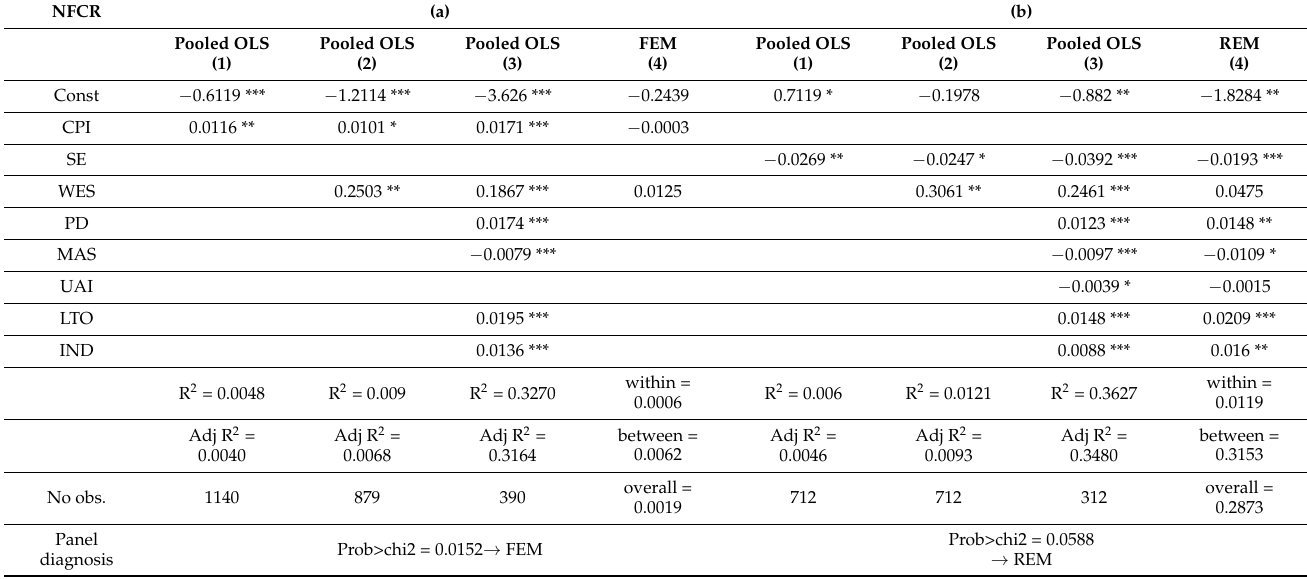
Table 6. Robustness